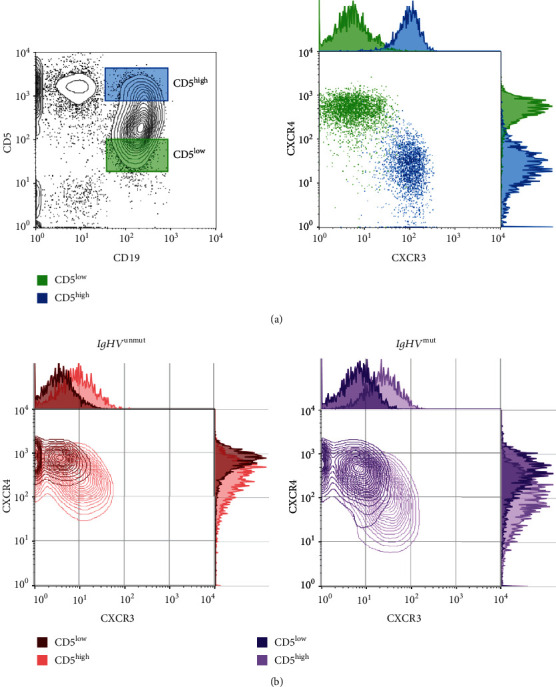
(a) Gating strategy for detection of CD5high and CD5low subpopulations within CD5+CD19+neoplastic cells and visualization of their CXCR3 and CXCR4 expression. (b) CXCR3 and CXCR4 expression on CD5high and CD5low subpopulations in IgHVunmut and IgHVmut patient—representative example.